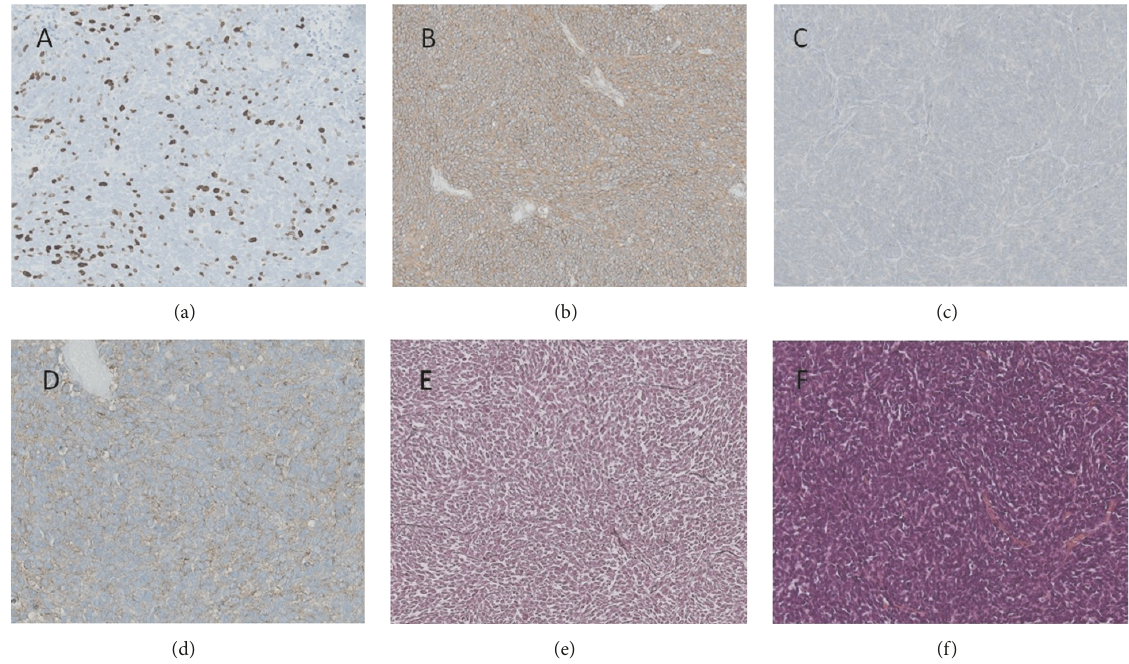
Figure 4: A small, round, blue cell, neuroectodermal tumor ((a), HE) without nodular architecture and without reticulin fiber network ((b), Gomori). Tumor cells showed expression of synaptophysin (c) but no expression of YAP1 and GAB1 (d). There was no nuclear expression of beta-catenin (e). Ki67-labelling reveals high proliferative activity